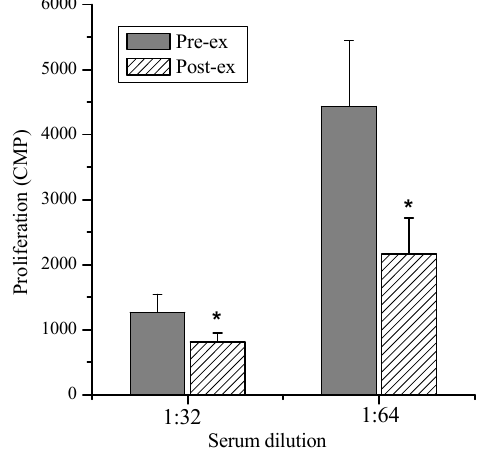
Figure 2. Effects of the sera obtained from subjects on normal mice lymphocyte proliferation. Data are presented as mean ± SD (n = 8). * P < 0.05, pre-exercise (Pre-ex) vs . post-exercise